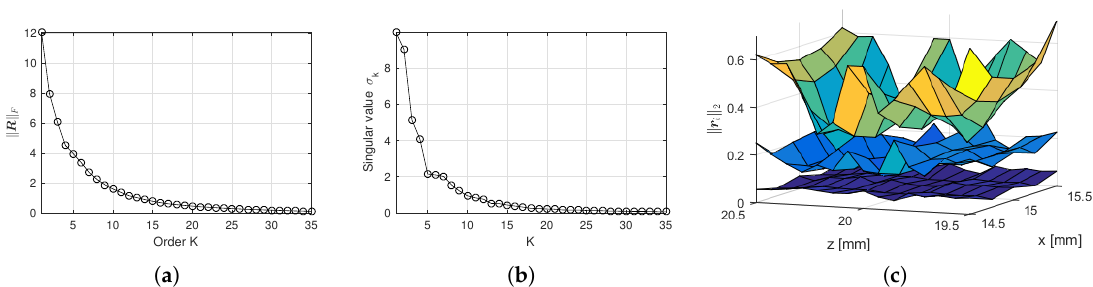
Figure 3. Approximation metrics for the centermost local ROI of the ultrasound acquisition set described in Section 6.1, with R = 75 ( R x = 5 and R z = 15). ( a ) Frobenius norm (cid:107) R ( n ) (cid:107) F of the residual matrix as a function of the order of approximation K ; ( b ) 35 first singular values σ k from the singular value decomposition of M ( n ) ; ( c ) individual residual norms (cid:107) r spatially arranged according to the corresponding positions on the local ROI. The three surfaces correspond to K = 5 (top), K = 10 (middle) and K = 20